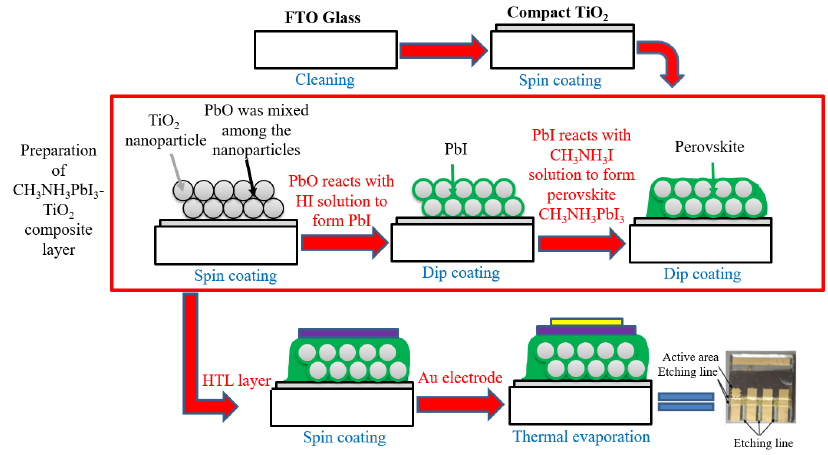
Figure 1. The preparation diagram for the PbO-TiO 2 mesoporous layer, CH 3 NH 3 PbI 3 /TiO 2 composite layer, and solar cell.